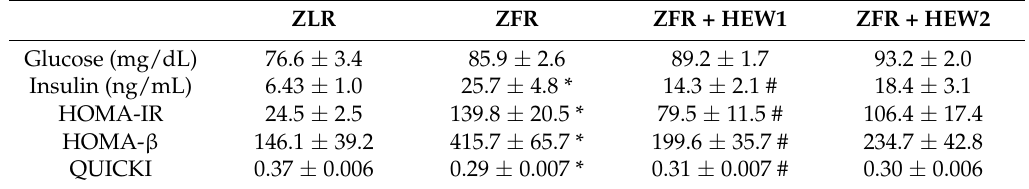
Table 1. Plasma glucose, plasma insulin and indexes of insulin resistance and insulin sensitivity.